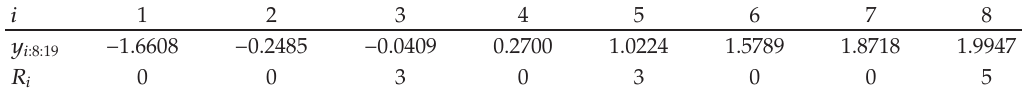
Table 10: Progressively censored sample generated by Nelson (cid:5) 23 (cid:6)